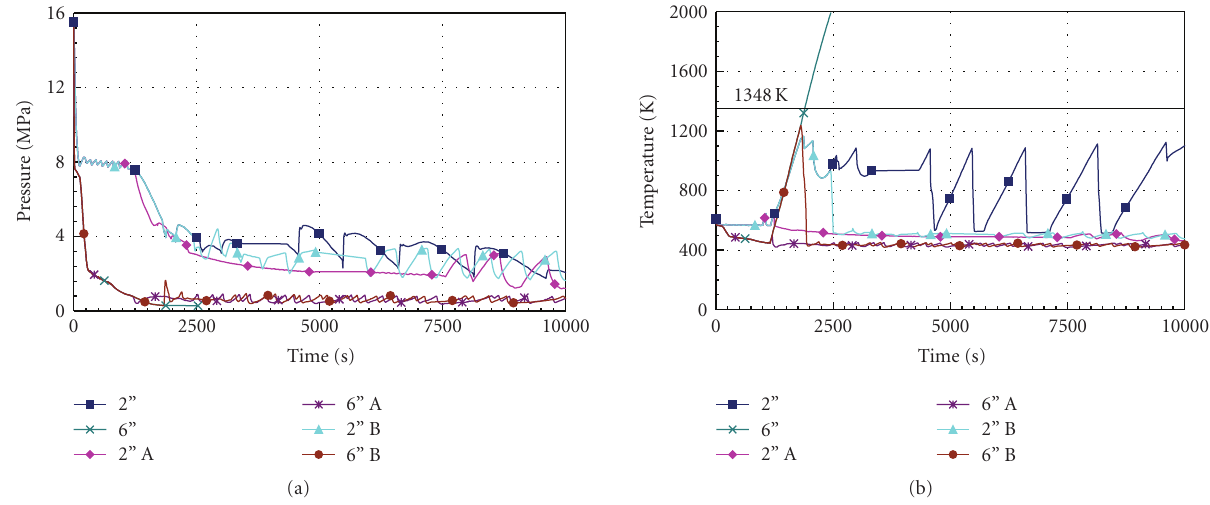
Figure 7: LOCA with manual actuation of SI: (a) RCS pressure, (b) core cladding temperature.